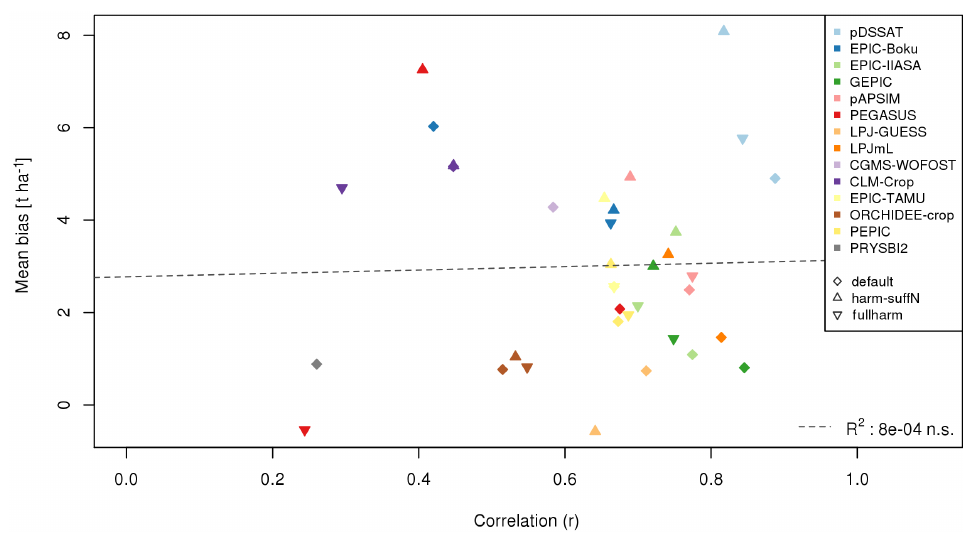
Figure 5. Relationship of global mean bias and time series correlation for maize across all GGCMs (colors) and harmonization settings (symbols). Dashed line indicates a linear fit, whose explanation power ( R 2 ) is given in the right-hand corner. Significance levels are as in Fig.